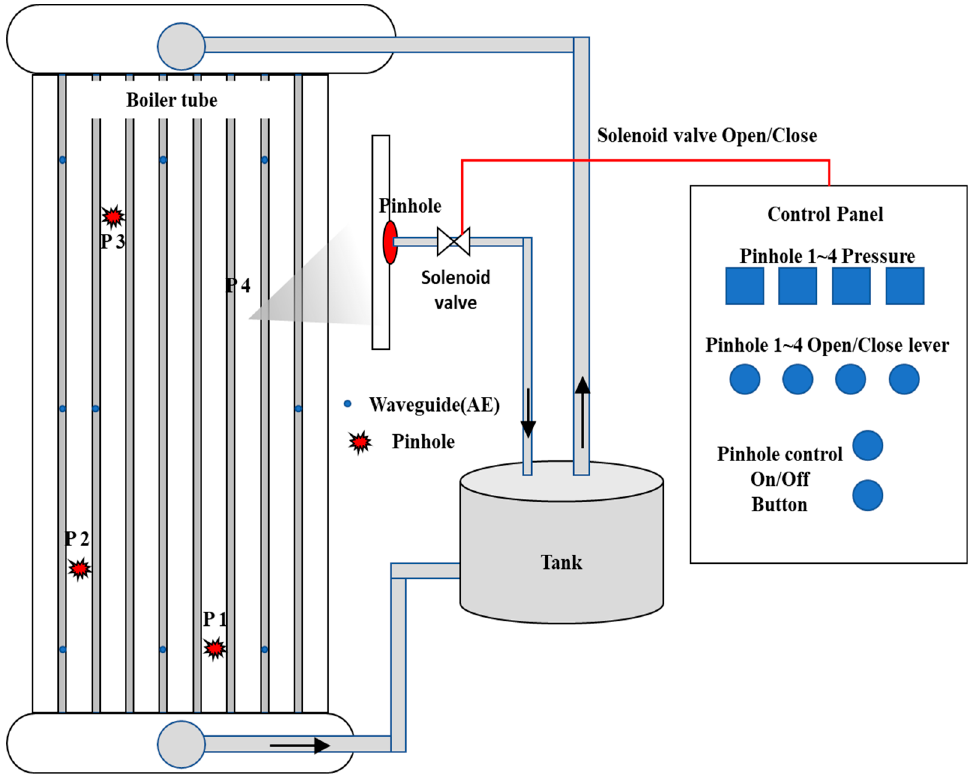
Figure 7. Testbed used for the experiment.